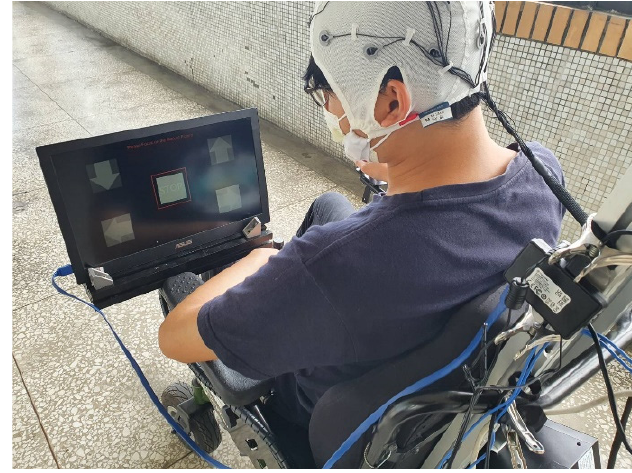
Figure 7. The configuration for the experiment using a screen.